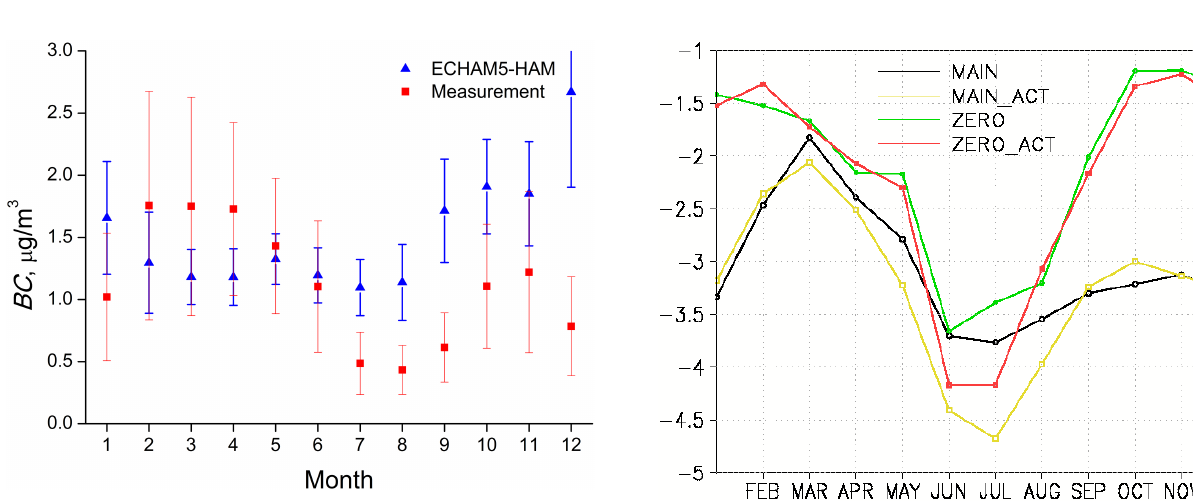
Figure 1. Surface BC concentration (in µgm − 3 ) in Mukteshwar measurements and in the grid point nearest to Mukteshwar in the NUDGE simulation, year 2006.